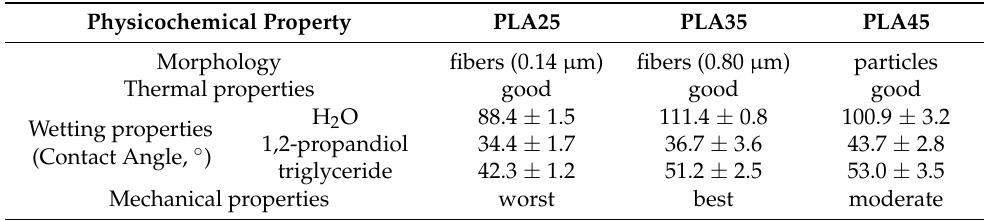
Table 3. Summary of the physicochemical properties of the three electrospun/electrosprayed PEG/PLA